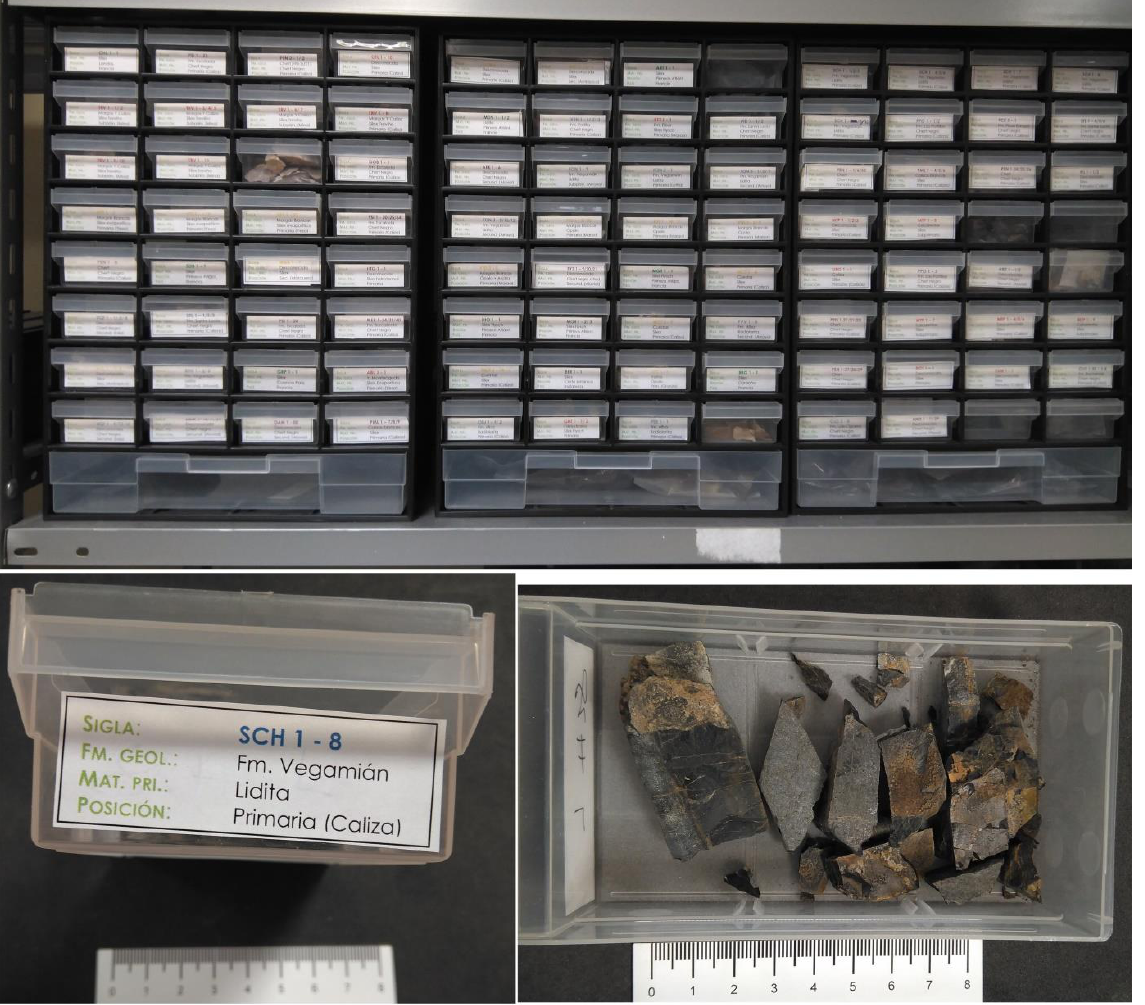
Figure 5: Pictures showing the organisation of the sample boxes (above), a detail of the labels of the sample boxes (below, left) and the inside of a sample box containing several samples (below,